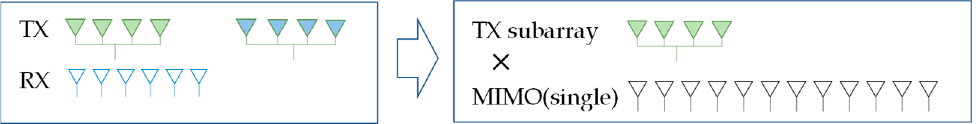
Figure 4. The final beampattern with TX subarrays and RX arrays shown on the left is the product of the beampattern of a TX subarray, and that of MIMO made by a single TX array is shown on the right. One TX subarray transmits the identical waveform.